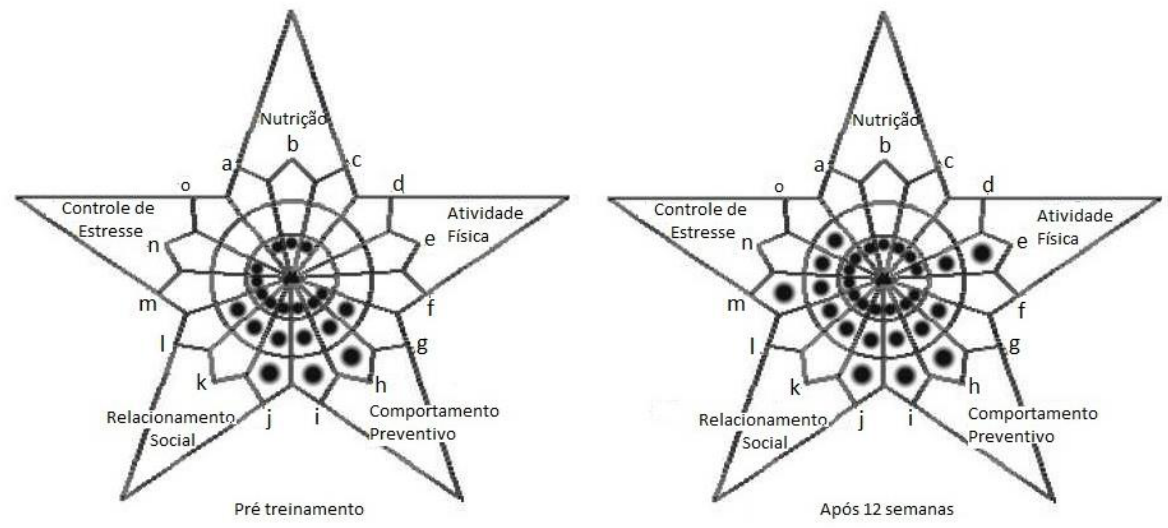
Figura 1. Respostas do questionário